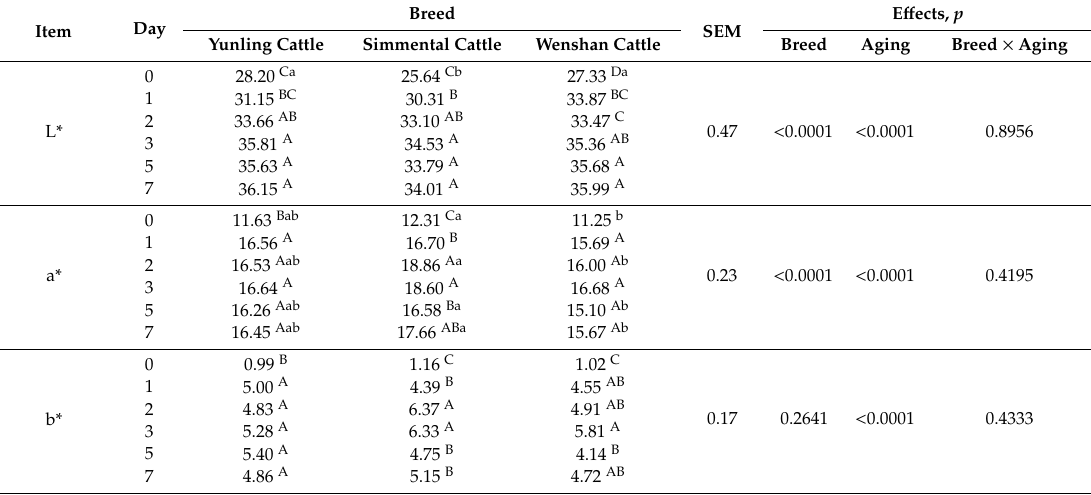
Table 6. Muscle color parameters measured at di ff erent aging